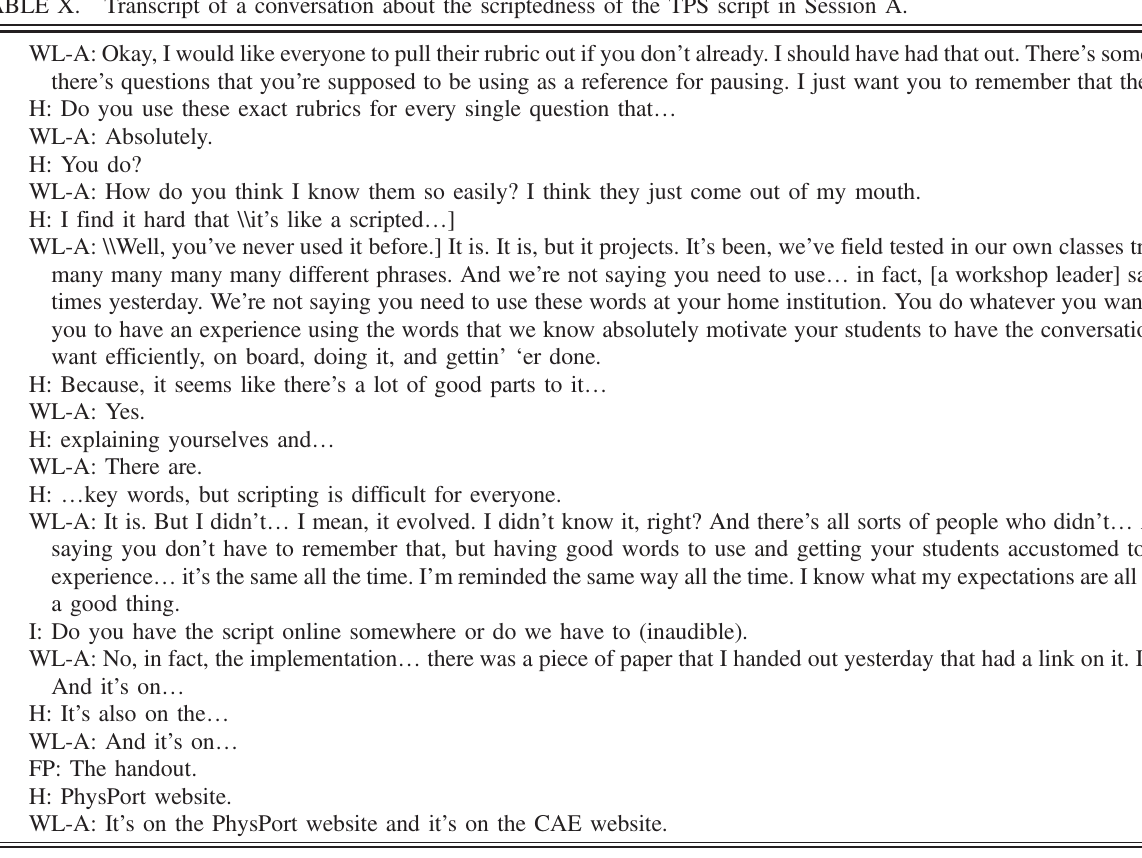
TABLE X. Transcript of a conversation about the scriptedness of the TPS script in Session